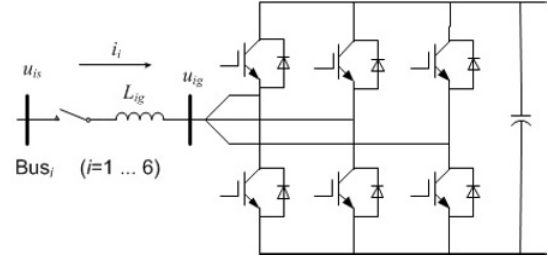
Figure 2. A topology of the VSC station